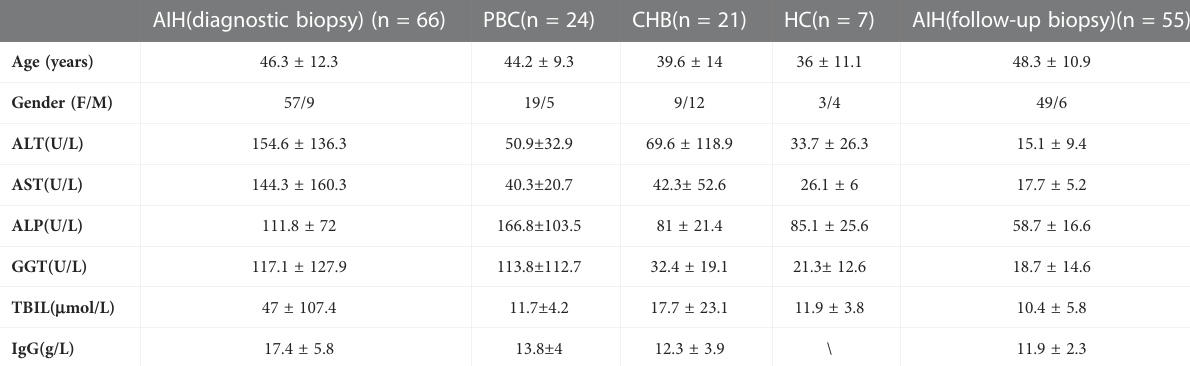
TABLE 1 Clinical Features of Patients with AIH, PBC, CHB, and